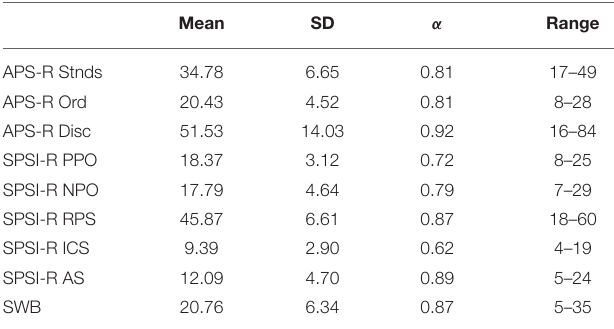
TABLE 1 | Means, standard deviations, Cronbach’s a and range of scores for perfectionism, social problem solving, and subjective well-being ( N =